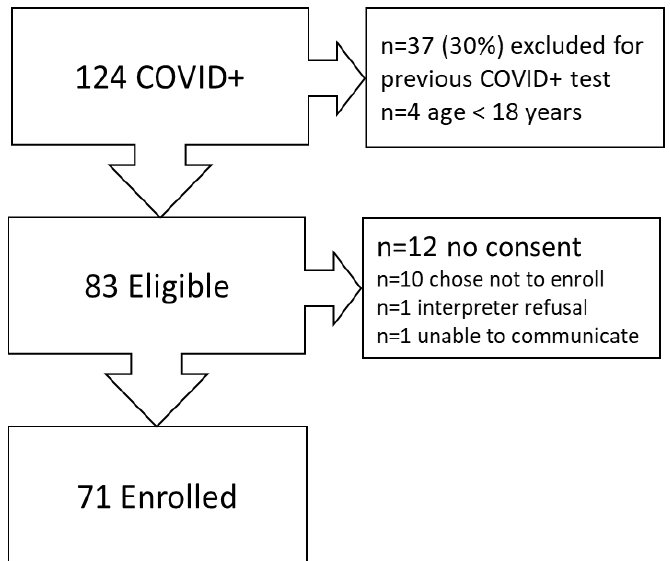
Figure 1. Flowchart of patient enrollment for expedited contact tracing of COVID-19 positive patients beginning in the ED at time of diagnosis. COVID, coronavirus disease.